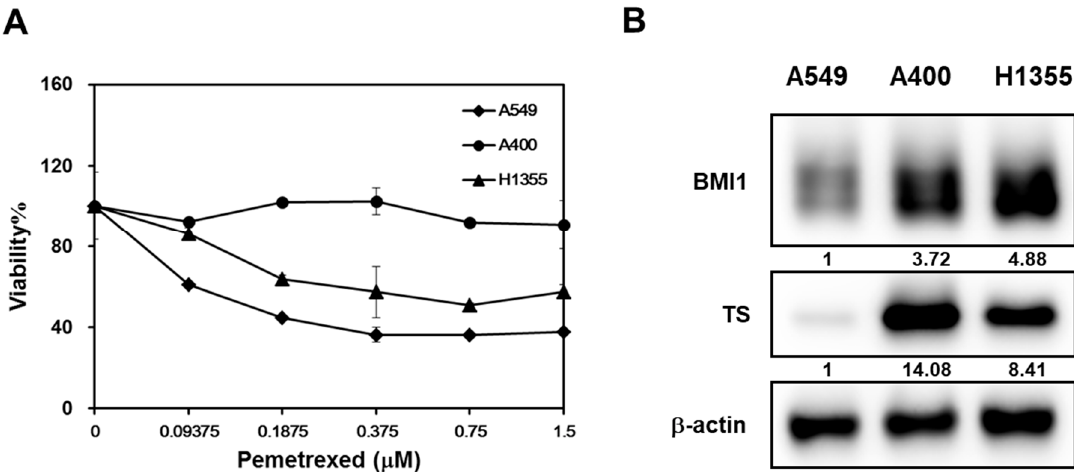
Figure 2. The expression level of B-cell-specific Moloney leukemia virus insertion site 1 (BMI1)/Specificity protein 1 (SP1)/thymidylate synthase (TS) is correlated with pemetrexed sensitivity in NSCLC cells. ( A ) Three NSCLC cells (A549, A400, or H1355) were seeded into a 96-well-plate at 1000 cells/well and treated with the indicated concentration of pemetrexed. The cell viability was determined by 3-(4,5-dimethylthiazol-2-yl)-2,5-diphenyltetrazolium bromide (MTT) reagent at 96 h after treatment. ( B ) The total proteins were harvested from three NSCLC cells and the expression of BMI1 or TS was determined by western blot. All the experiments were done three times and data from one experiment were presented.